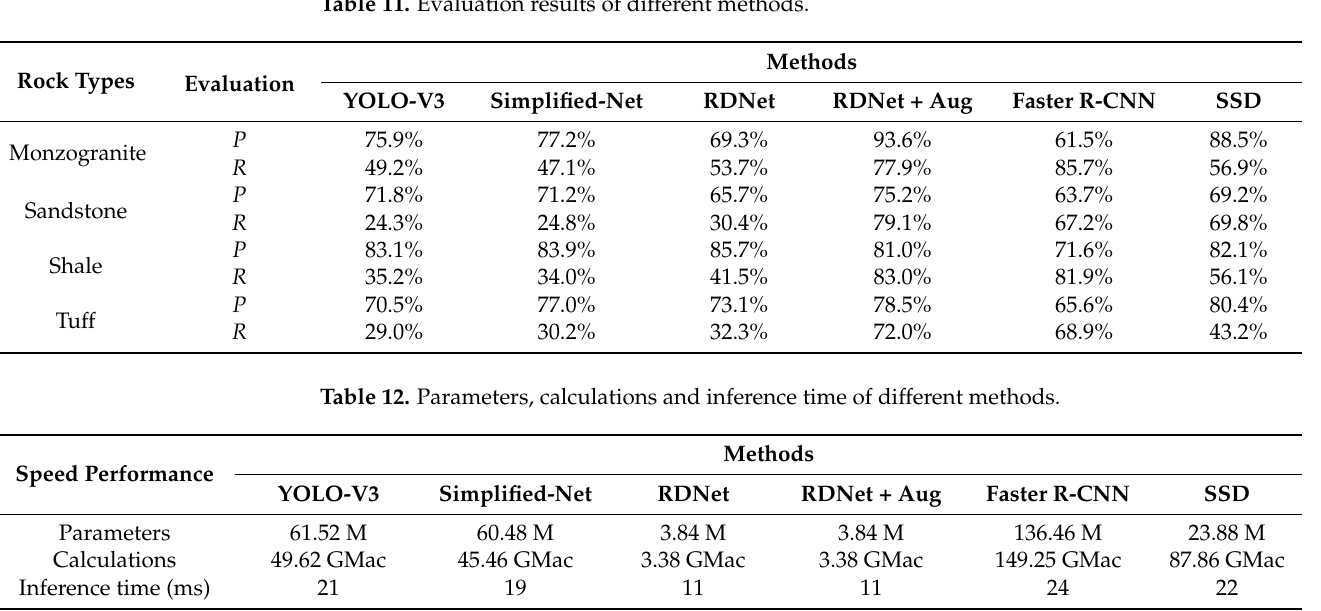
Table 11. Evaluation results of different methods.